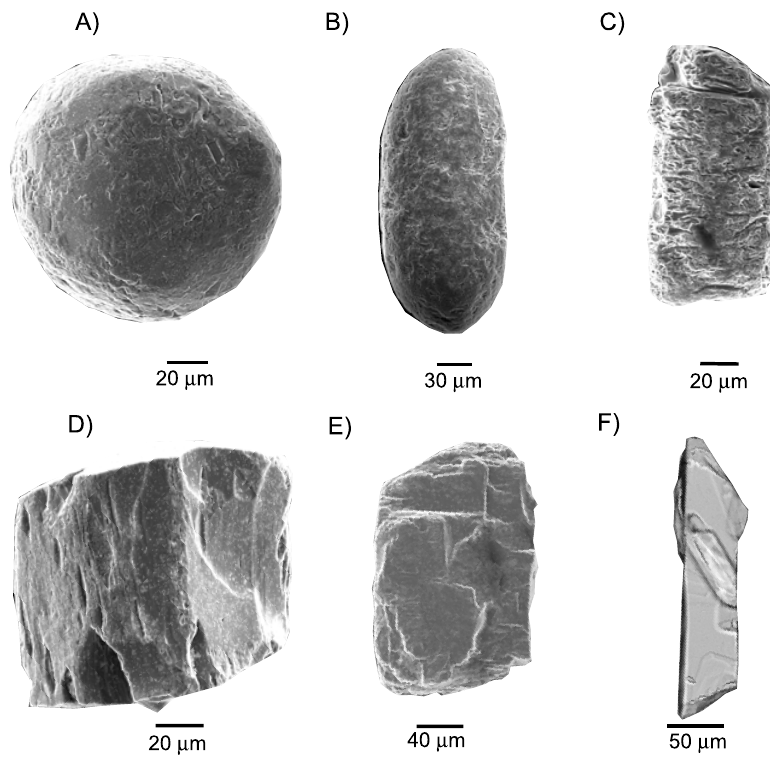
Fig. 6 – Main characteristics of the heavy minerals from the upper kaolin unit, illustrating: A) rounded zircon; B) rounded tourmaline; C) very altered tourmaline; D) partly altered staurolite; E) partly altered kyanite; and F) unaltered staurolite from the layers of quartz sandstones that occur within the semi-flint